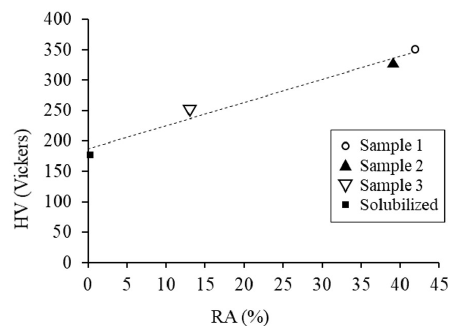
Figure 2. Dendritic microstructure of solubilized superaustenitic steel (Aqua Regia - MO).